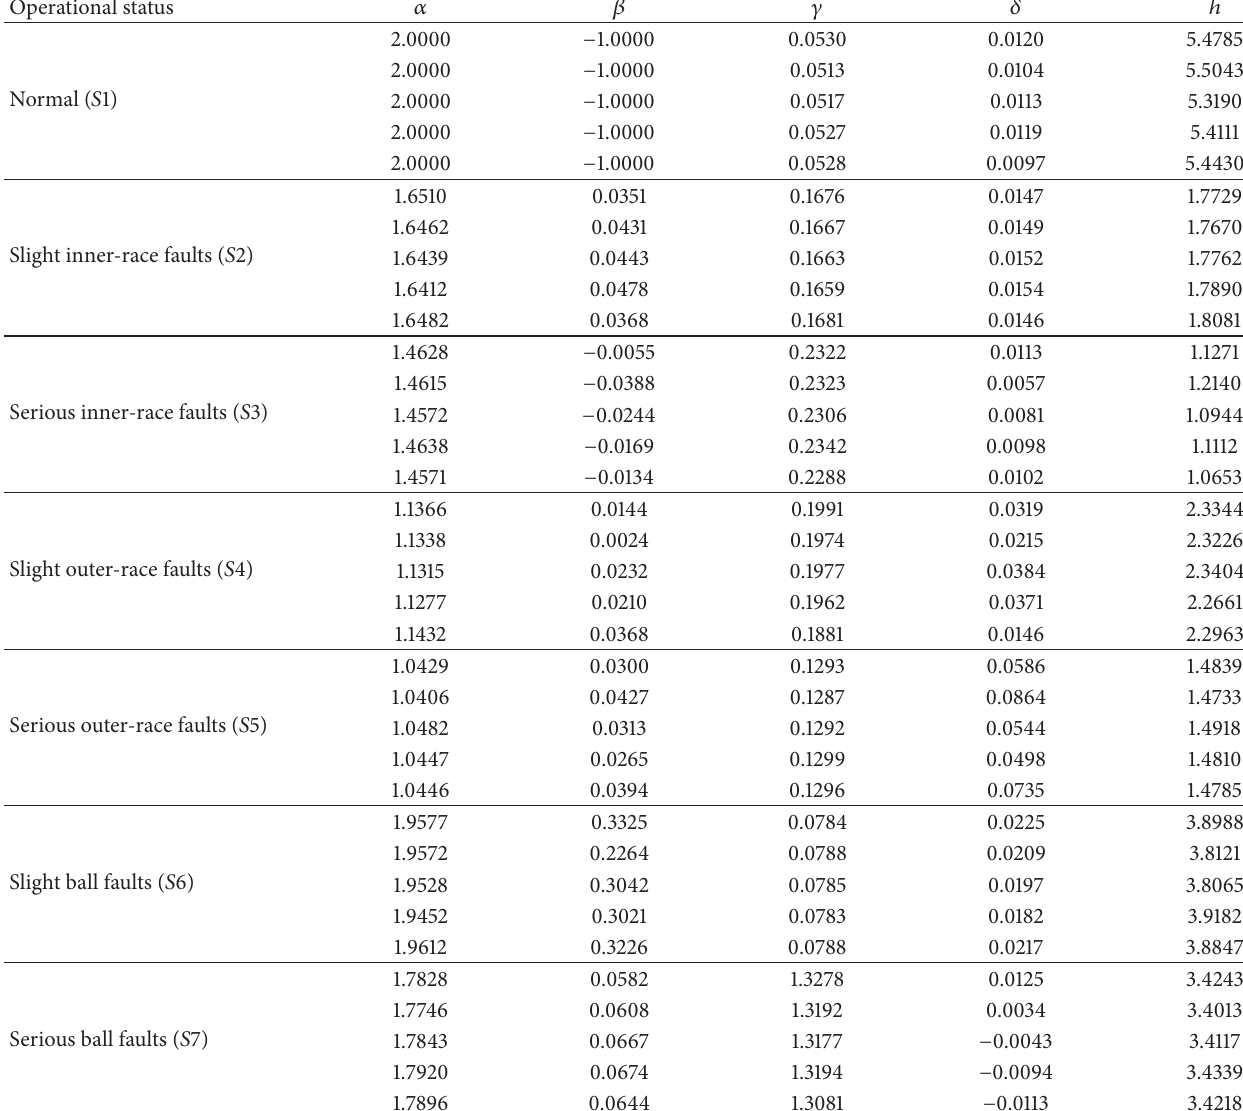
Table 3: The ASD features of seven vibration